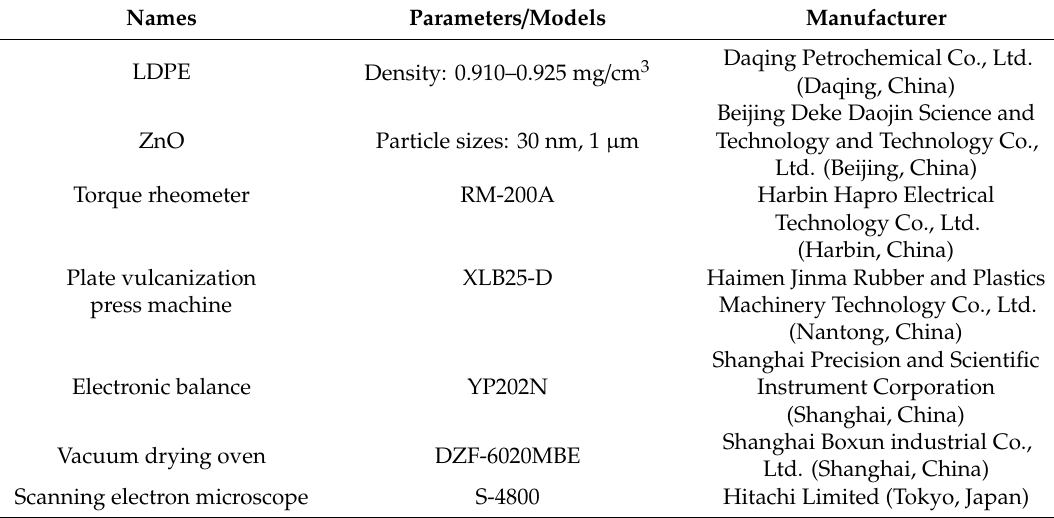
Table 1. Experimental materials and